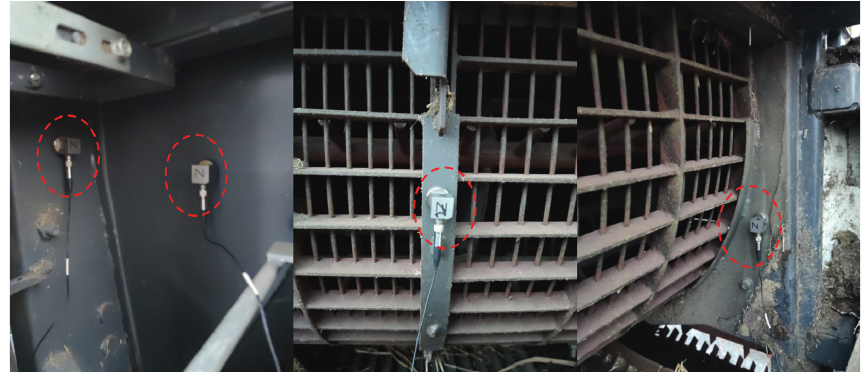
Figure 3: Sensor installation location.